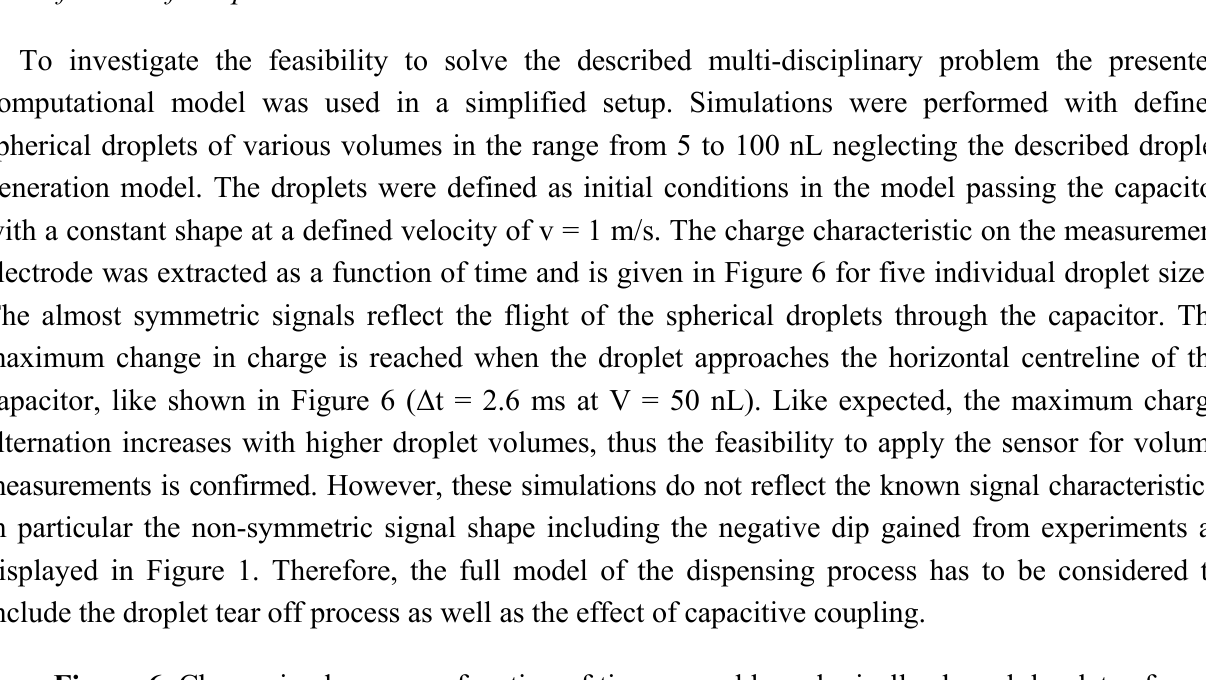
Figure 6. Change in charge as a function of time caused by spherically shaped droplets of different volumes passing the capacitor as shown in the illustration for a spherical droplet of V = 50 nL at three specific points in